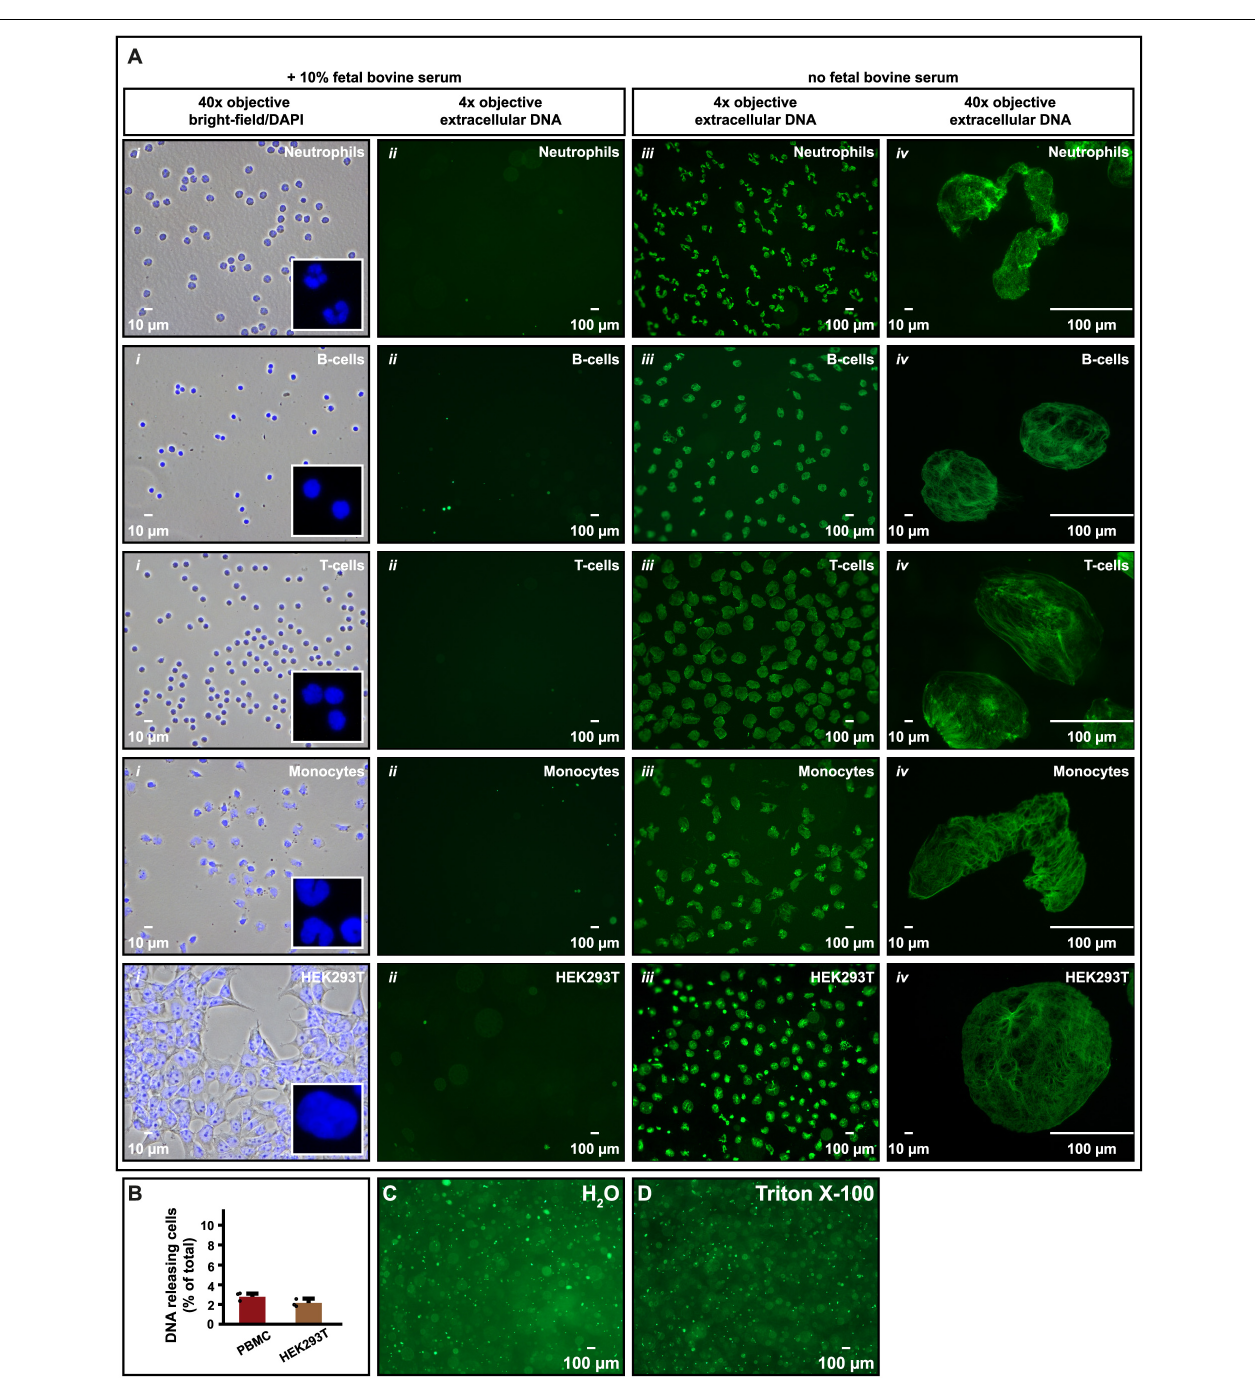
FIGURE 3 | DNA release is not restricted to hematopoietic cells. (A) Microscopy images of human neutrophils, B-cells, T-cells, and monocytes as well as HEK293T cells in cell culture medium with or without 10% FBS as supplement. In i , cells were fixed and stained with DAPI to visualize the size and shape of nuclei in physiological conditions for comparison ( i ; 40 × objective). To further highlight the shape of the nuclei, parts of the images were enlarged (white box). ii and iii are microscopy images (4 × objective) of extracellular DNA in supernatants released from cells after 30 min in FBS containing ( ii ) or FBS deprived ( iii ) cell medium after staining with SYTOX Green nucleic stain. In iv , released DNA in iii was captured on a glass slide and imaged using the same magnification as in i (40 × objective) to highlight the shape and size of the released DNA. (B) Number of PBMC and HEK293T cells, expressed as percentage of total, releasing DNA extracellularly when seeded in serum-free medium. All released DNA entities were counted and related to the total number of cells in the experiment. N = 3. (C,D) Extracellular DNA released from Nalm-6 cells seeded in deionized water (C) or in 10% Triton X-100 in PBS (D) and stained with SYTOX Green. Microscopy images of extracellular DNA in panels (C,D) were obtained using 4 ×